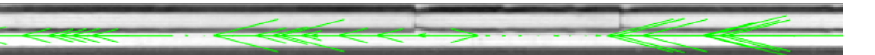
Figure 27. Distribution of velocity vector along the pipe in the experiment with 100 W input power in turbulent flow and ethanol as working fluid—52.6% filling